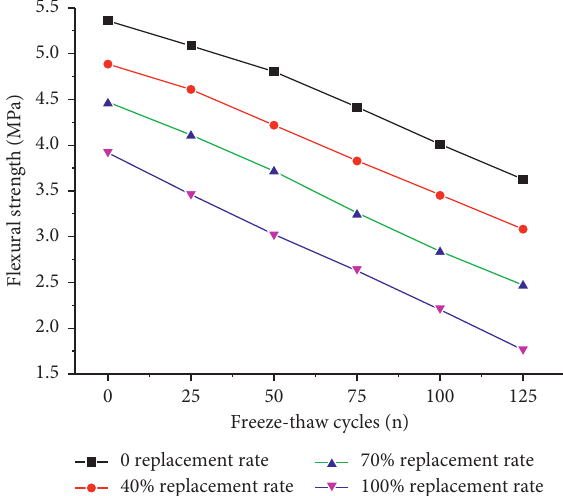
Figure 5: Compressive strength of coal gangue concrete under freeze-thaw cycles.